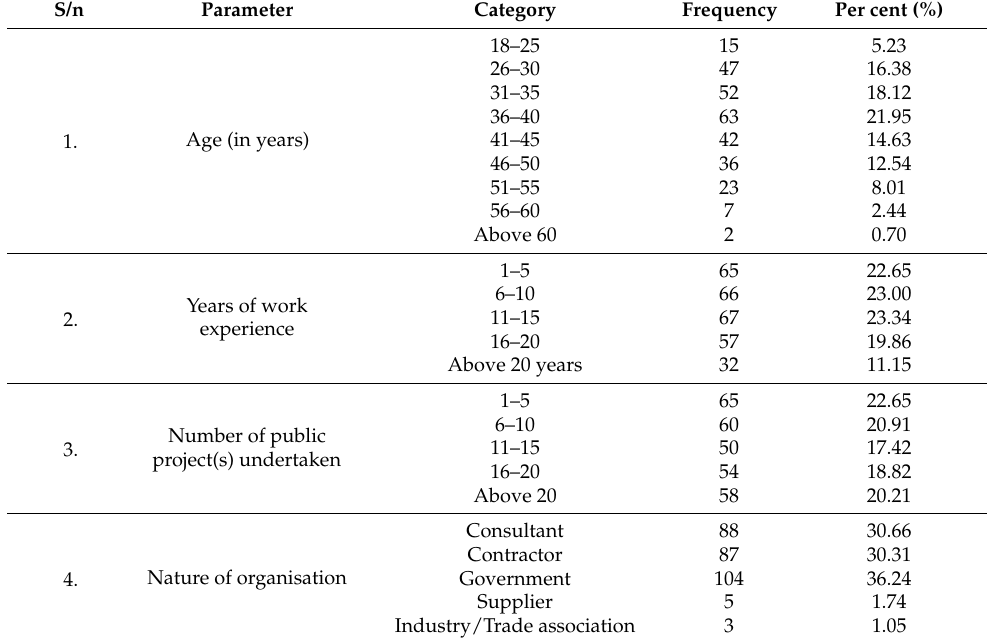
Table 1. Demographic profile of